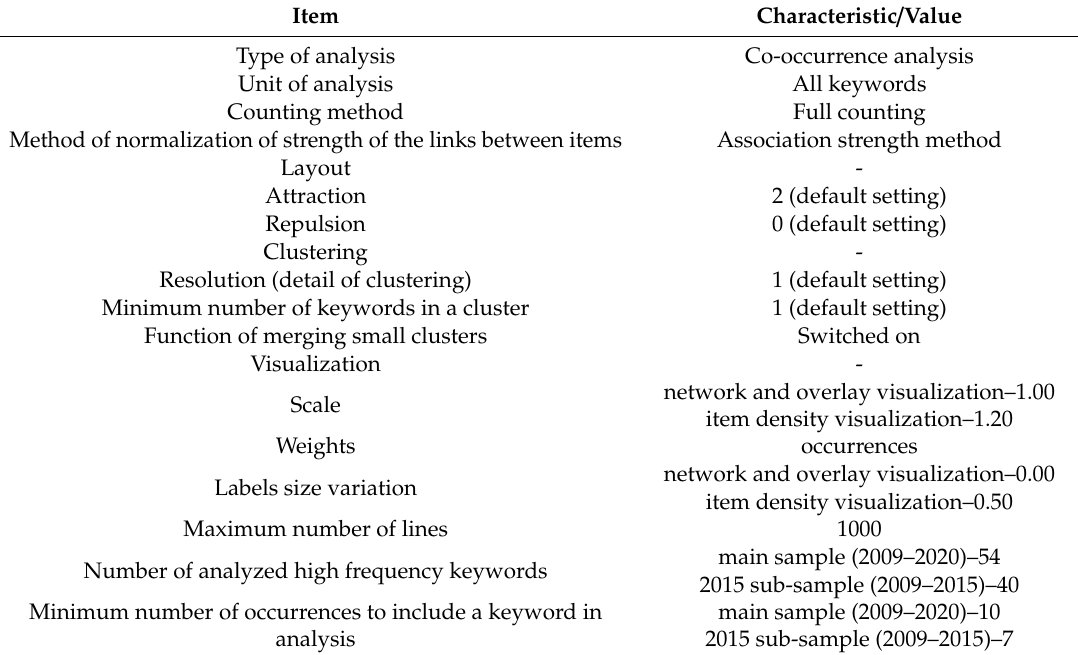
Table 2. VOSviewer settings.